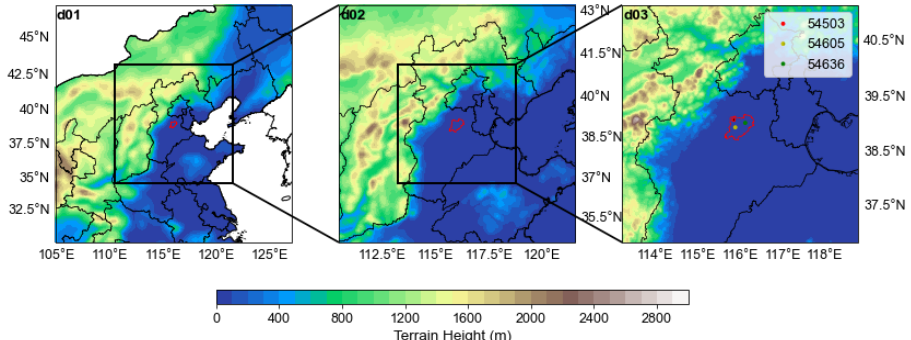
Figure 1. Three nested domains for sensitivity simulations and national basic weather stations are also shown (Rongcheng: 54,503, Xiongxian: 54,636, Anxin: 54,605). The BEP scheme and BEP + BEM scheme can only be used with Mellor-Yamada-Janjic (MYJ) PBL, Yonsei University (YSU) PBL and Boulac PBL in the WRF (V4.3.2) model. The